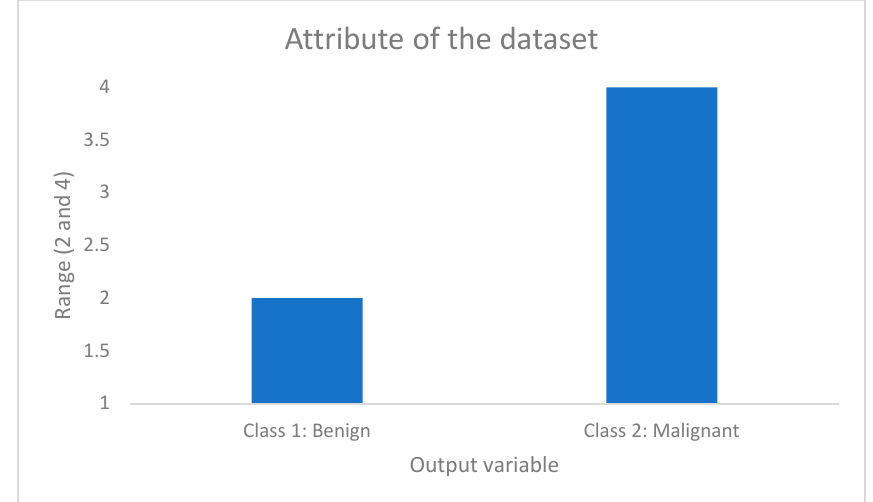
Figure 3. Output variable of the Wisconsin Breast Cancer dataset. Table 1. Confusion matrix for WCDB dataset.